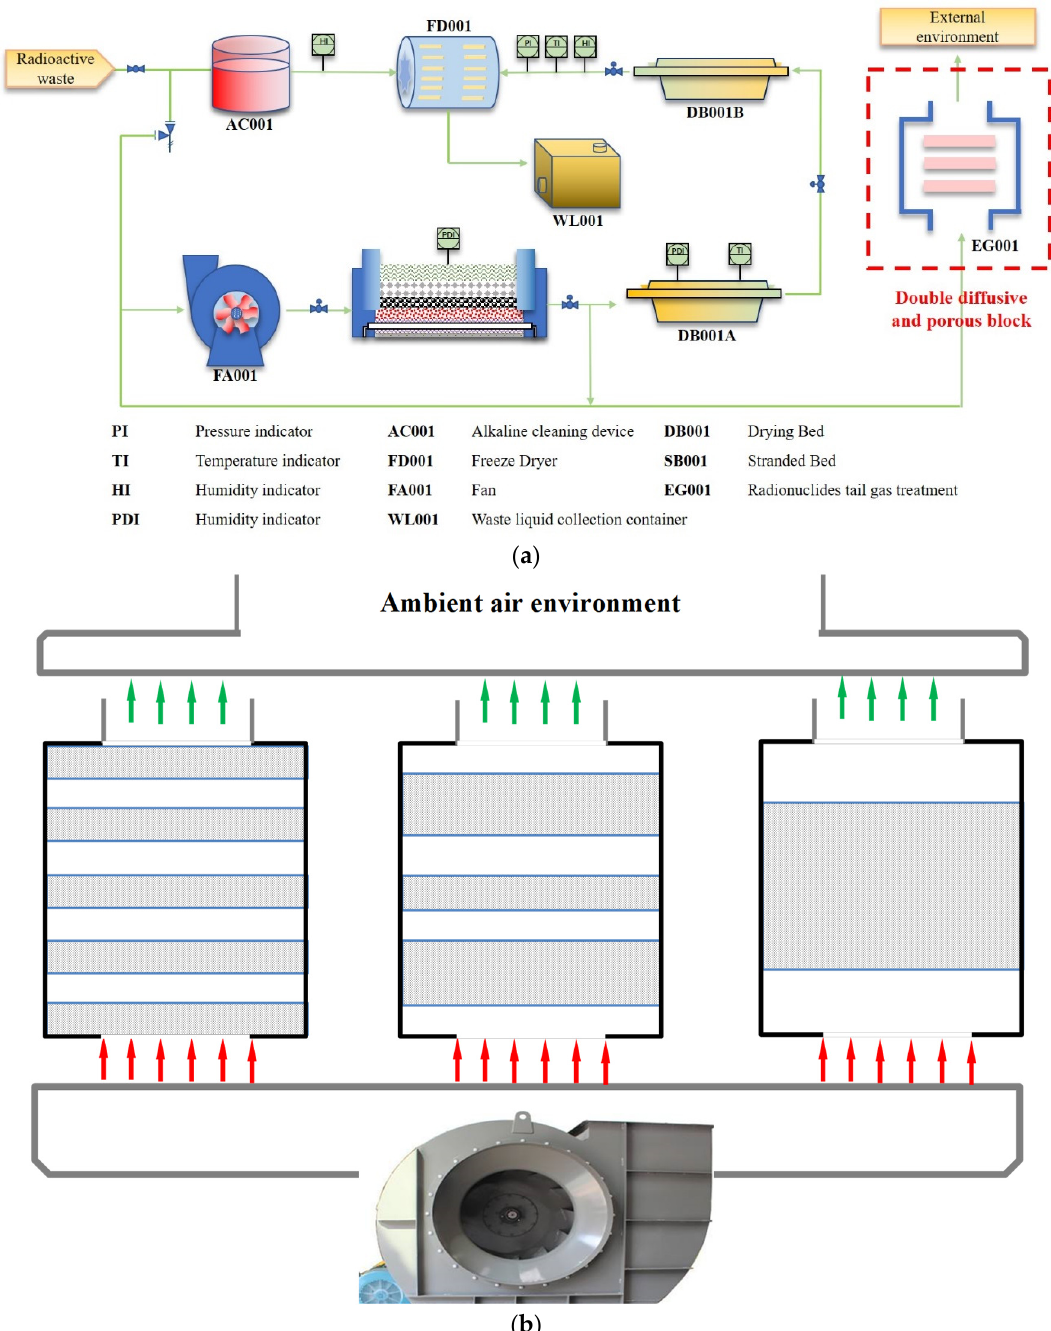
Figure 1. General presentation of a radionuclides tail gas treatment unit, ( a ) Typical process, and ( b ) Inner structures.